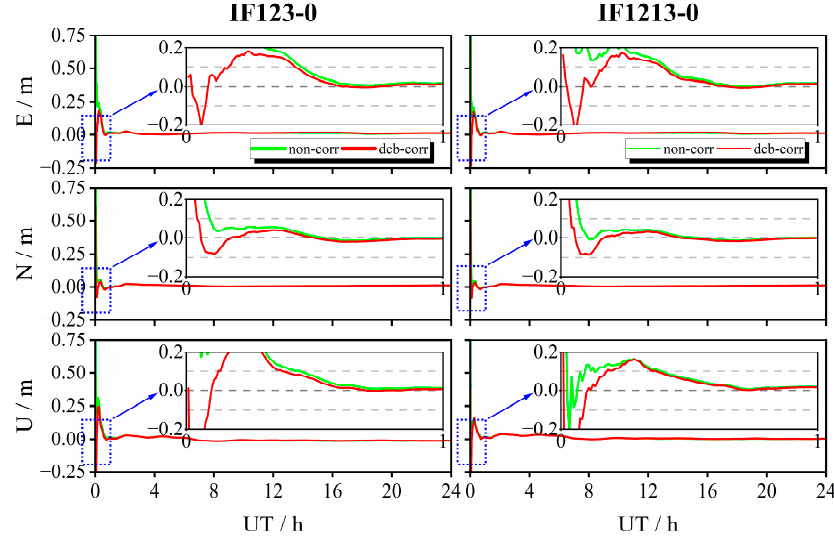
Figure 8. Positioning errors of IF123-0 and IF1213-0 at AREG station; 24-h time series.